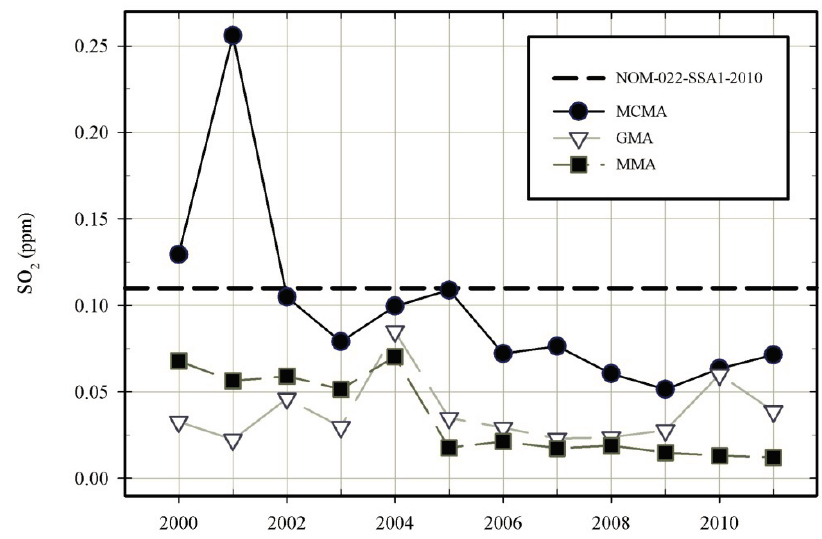
Figure 9. Maximum values of 24-h averages of SO metropolitan areas. The dashed horizontal line indicates the MPL in Mexico.